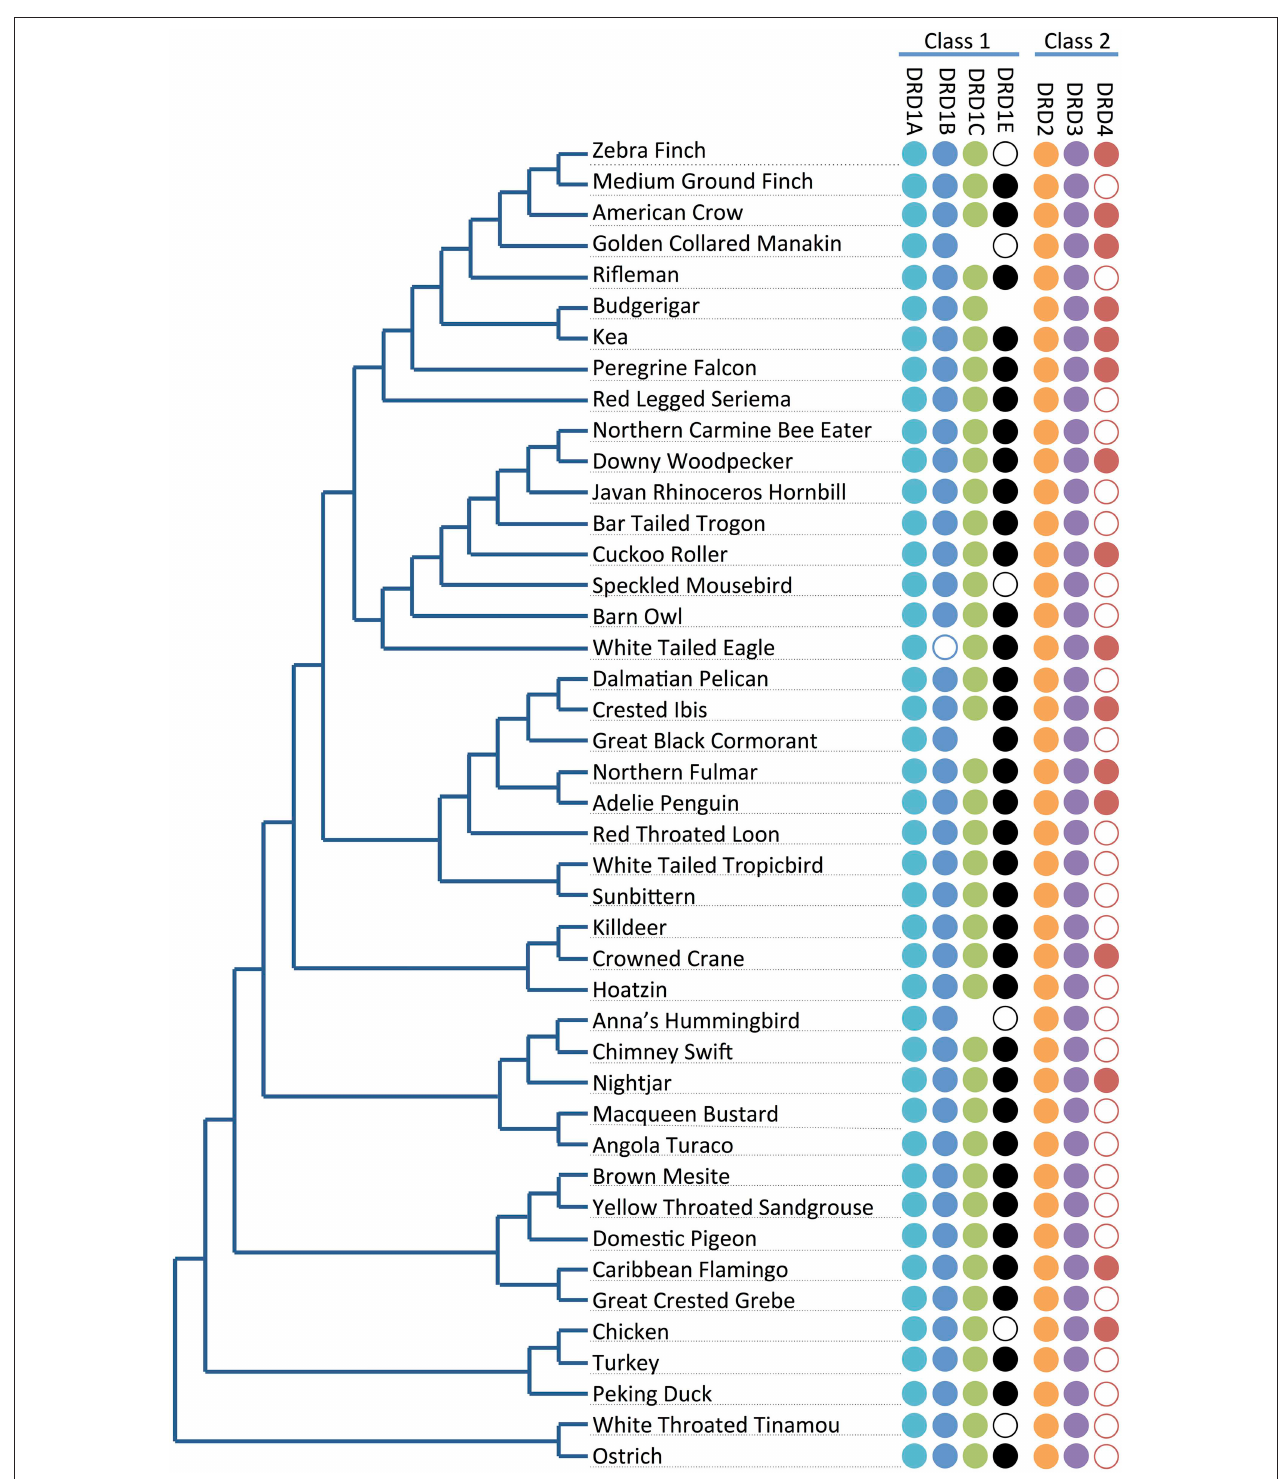
FIGURE 2 | Receptor presence/absence by species. Presence and absence of dopamine receptors (right) across the phylogeny of the 43 investigated bird species (left; tree adapted from Jarvis et al., 2014). Full circles indicate receptor genes are present and identified. Empty circles indicate receptor genes not annotated in the genome, but with at least significant portions of the sequences identified by microsynteny analysis (e.g., Figure 3B ) or BLAST searches against raw sequencing reads (Supplementary File 1). No circles represent receptor genes are likely absent in that species due to not being found through any analyses. Losses do not follow a phylogenetic pattern, and thus appear to be lost independently in different lineages.